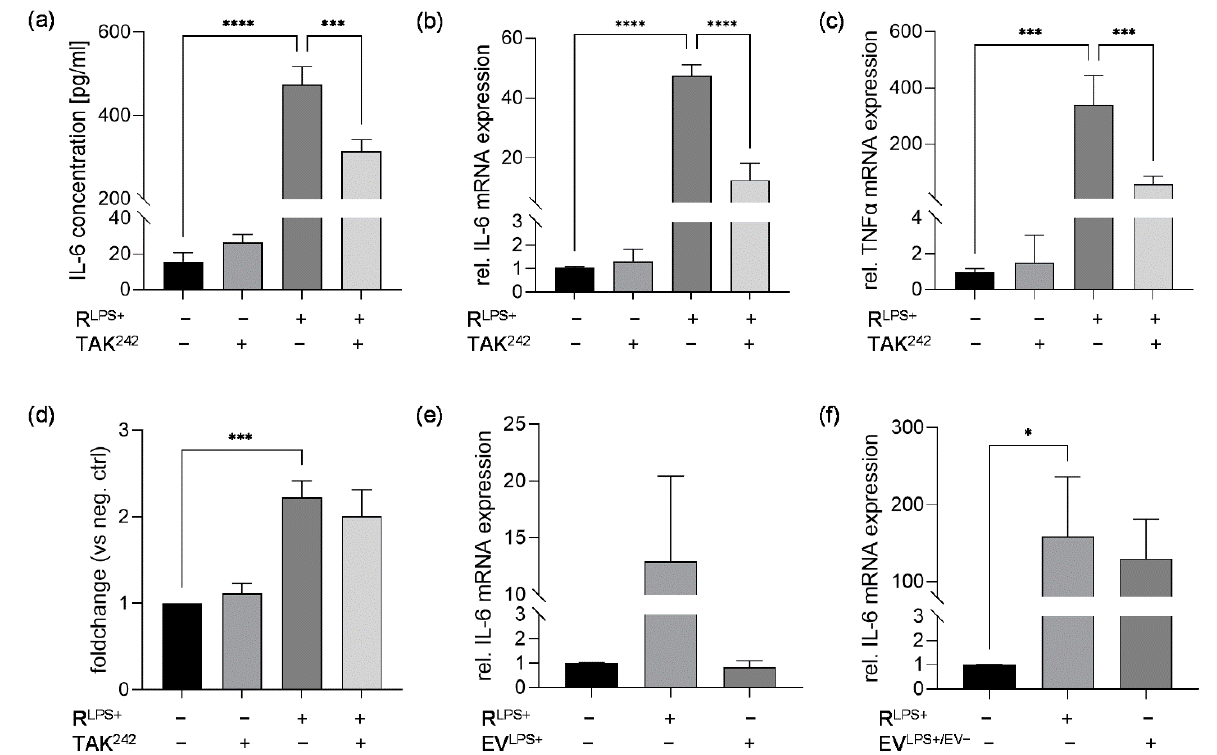
Figure 4. The effects of TLR4 inhibition on cardiomyocytes exposed to conditioned of LPS-stimulated macrophages and cardiomyocyte exposure to either isolated EVs generated from conditioned medium of LPS-stimulated macrophages or EV-depleted conditioned medium of LPS-stimulated macrophages in terms of cardiac inflammation and/or caspase-3/7 activation. Cardiomyocytes exposed to conditioned medium of LPS-stimulated macrophages (R LPS+ ) in the presence or absence of 20 µM TLR4 inhibitor (TAK 242 ) for 6 h compared with unstimulated cells and TLR4 inhibitor were analyzed (n = 3). ( a ) IL-6 protein concentrations were measured utilizing ELISA. Relative mRNA expression of ( b ) IL-6 and ( c ) TNF α were determined by quantitative real-time PCR. ( d ) Relative casapase-3/7 activation was assayed using Caspase Glo Assay. Relative IL-6 mRNA expressions of cardiomyocytes stimulated with either ( e ) isolated EVs generated from conditioned medium of LPS-stimulated macrophages (EV LPS+ , n = 2) or ( f ) EV-depleted conditioned medium of LPS-stimulated macrophages (R LPS+/EV − , n = 3) are presented. Data are presented as column bar graphs as the mean ± SD. One-way ANOVA followed by Tukey’s test was used for multiple comparisons. * p < 0.05; *** p < 0.001; **** p < 0.0001; LPS = lipopolysaccharide; TLR4 = toll-like receptor 4; IL-6 = interleukin-6; TNF α = tumor necrosis factor alpha; EVs = extracellular